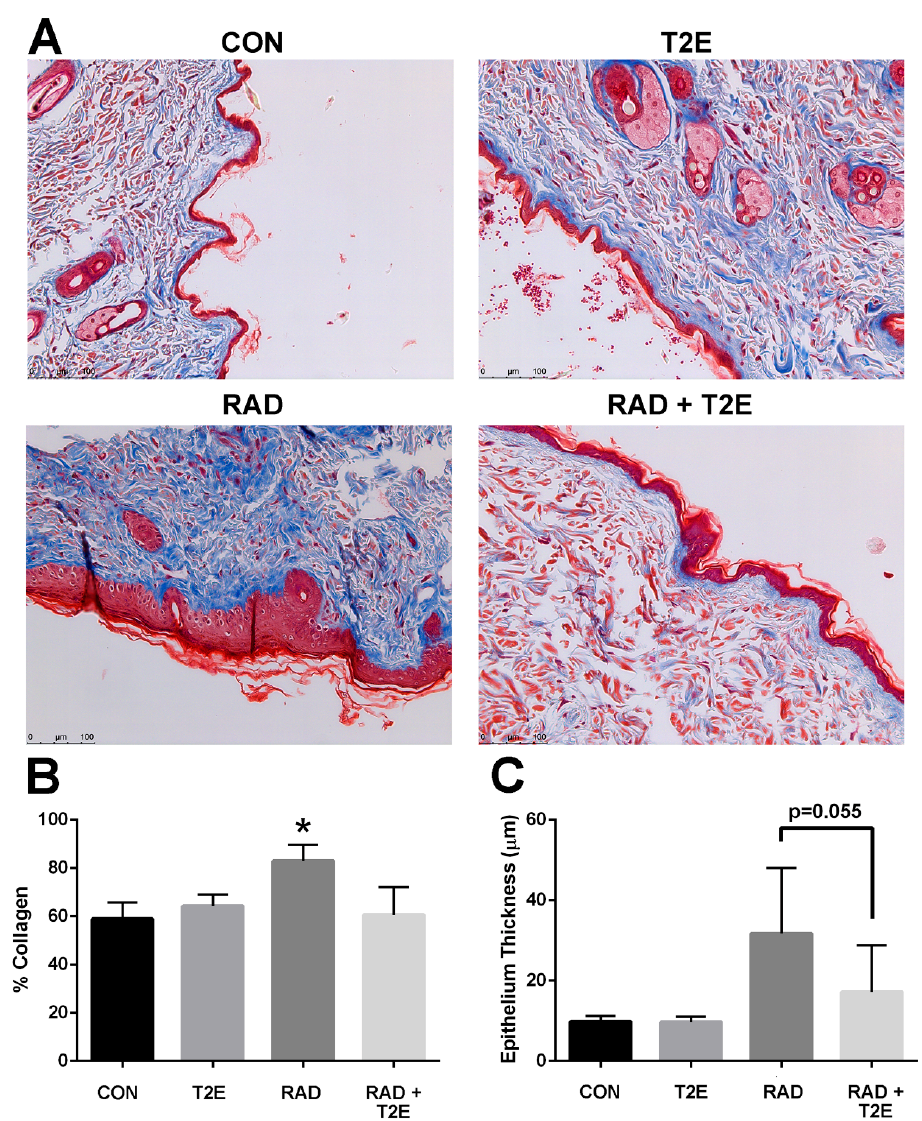
Figure 8. MnTE-2-PyP treatment inhibits fibrosis in skin tissues at 6 months post-irradiation. ( A ). Representative sections of skin tissues stained with trichrome to observed collagen deposition from each of the four groups: Control (PBS), MnTE-2-PyP treated alone, Radiation + PBS and Radiation + MnTE-2-PyP. ( B ). The average percent collagen deposition for each group. ( C ). The average epithelium thickness. A 1-way ANOVA followed by post hoc Tukey’s test for multiple comparisons was used to determine differences between groups. The symbol (*) denotes a significant difference as compared to the control group. Magnification bar = 100 µm. There were 5–9 animals/group. Red = cytoplasm, muscle, keratin. Blue = collagen. Black = nuclei.